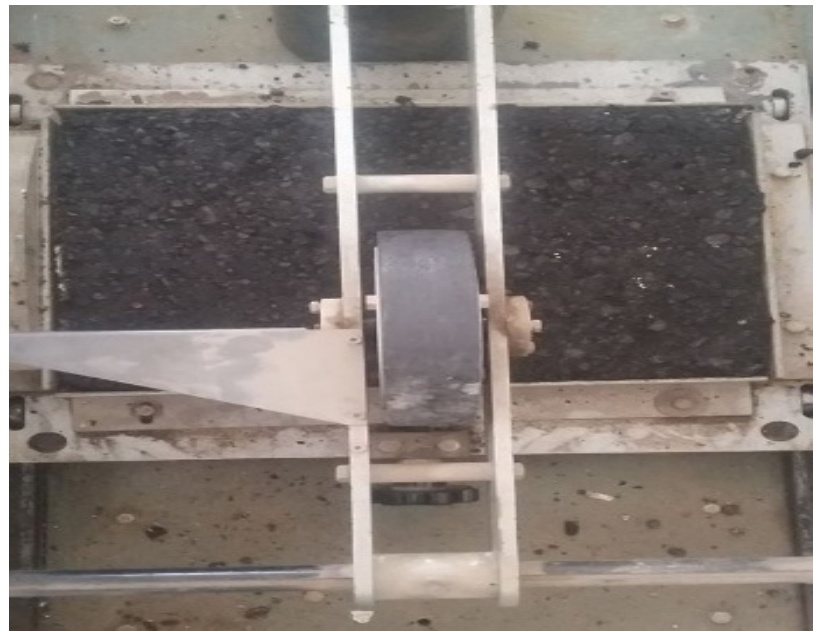
Figure 5. Slab under wheel load.